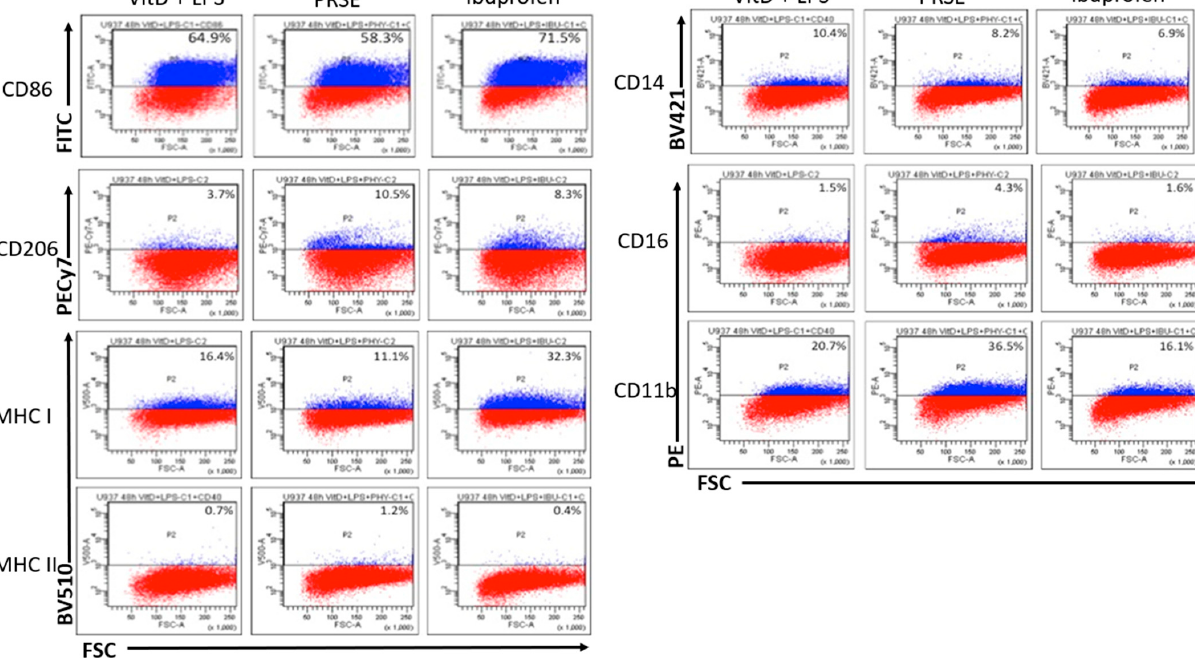
Figure 2. Expression of cell surface markers after 48 h of incubation by flow cytometry: PE, phycoerythrin; AF, Alexa Fluor; PE-Cy7, phycoerythrin-cyanine 7; BV, Brilliant Violet.